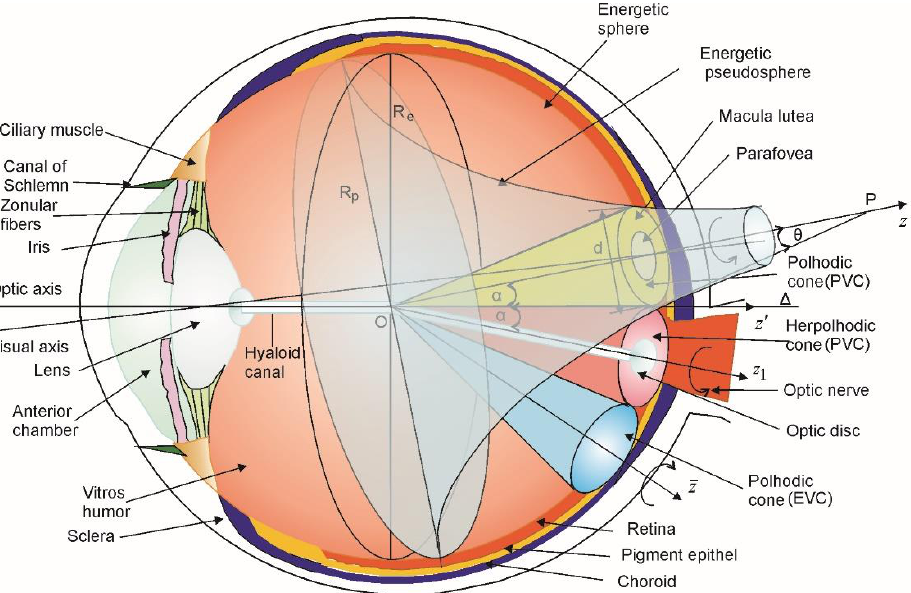
Figure 1. The polhodic and herpolhodic charge vortices are superposed on the main human eye structures represented after [28] .